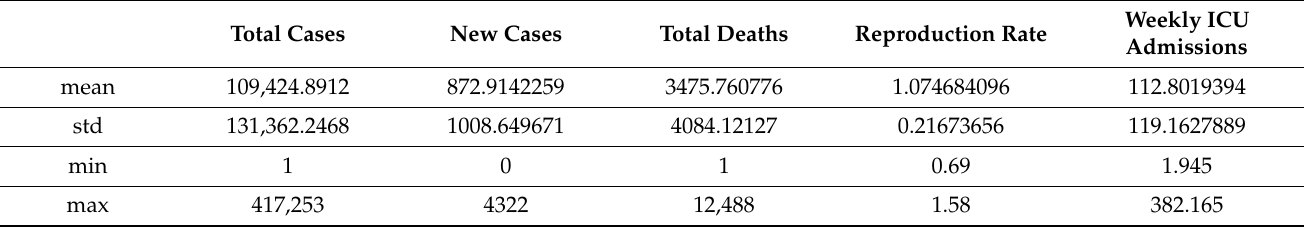
Table 1. Pandemic Statistic Analysis_1.